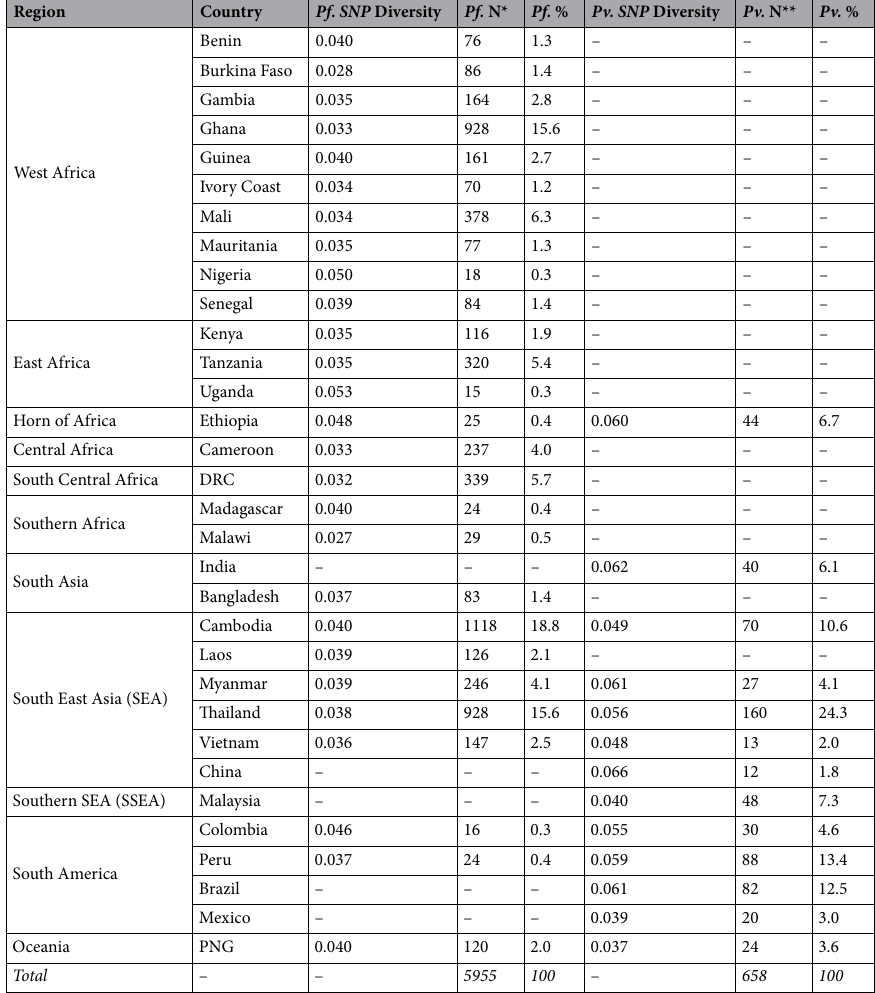
Table 1. Sample origin and SNP Diversity by geographic location. Pf P. falciparum , Pv P. vivax ; PNG Papua New Guinea; DRC Democratic Republic of